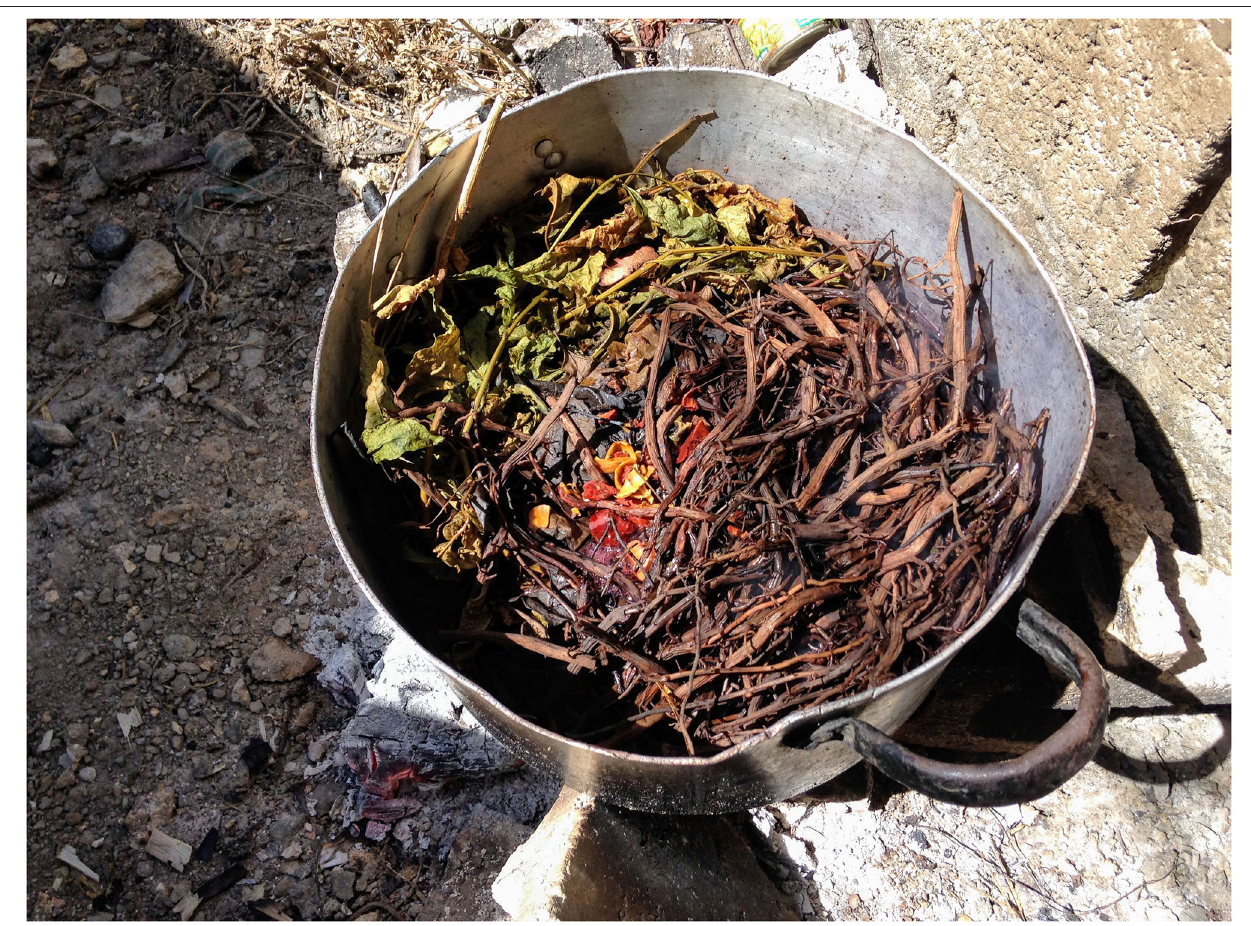
FIGURE 4 | Preparation of a root tonic showing boiled plant ingredients after decantation of the liquid. Often, depending on the producer, new water is added for a “second boil.” This process can take several hours to an entire day (photo credit